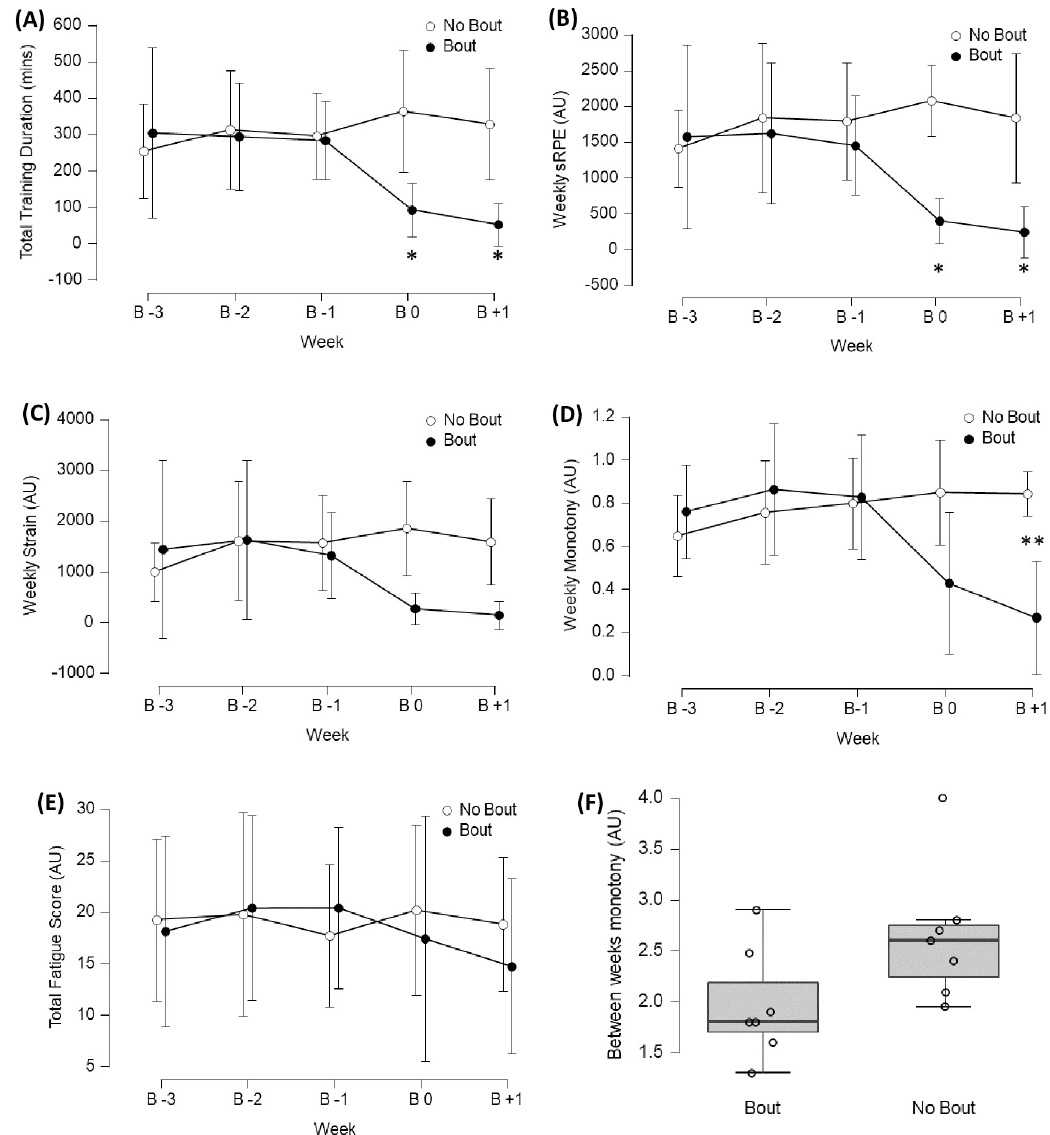
Fig 3. Plots A-E: Between week comparisons of training load variables and fatigue score split by bout and no bout. B = weeks before/after bout; � between weeks and between groups differences; �� between weeks differences only, Error bars = 95% credible intervals. Plot 3F: comparison of between weeks monotony between groups, Median [10–90%]. drills (BF = 14) with no other differences between categories. BJJ sparring produced greater 10 load than striking (BF = 651) and wrestling sparring (BF = 992), without any relevant dif- 10 10 ference to MMA sparring. Wrestling sparring also caused lower load than MMA sparring (BF = 1.240e +6 ). There was a general trend for technical drills to cause a greater load than 10 sparring, with striking drills segRPE being decisively greater than striking (BF = 11,167) and 10 wrestling sparring (BF = 25,578). BJJ drills also induced greater loads than striking sparring 10 (BF = 21,540) and wrestling sparring (BF = 24,453). Only MMA sparring was found to 10 10 elicit statistically greater loads than wrestling drills (BF = 217). S&C segRPE was found to be 10 greater than all other categories (BF = 14–1.335e +85 ). Wrestling sparring load was found to 10